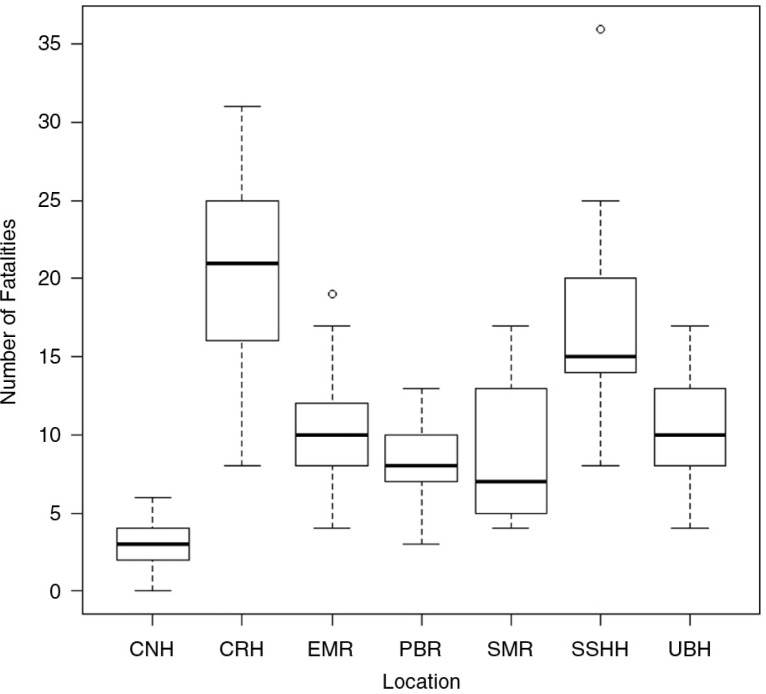
Number of fatalities that occurred on different roads in Trinidad and Tobago (from 2000 to 2011). CNH, Claude Noel Highway; SSHH, Sir Solomon Hochoy Highway; UBH, Uriah Butler Highway; SMR, Southern Main Road; PBR, Priority Bus Route; EMR, Eastern Main Road; CRH, Churchill–Roosevelt Highway.